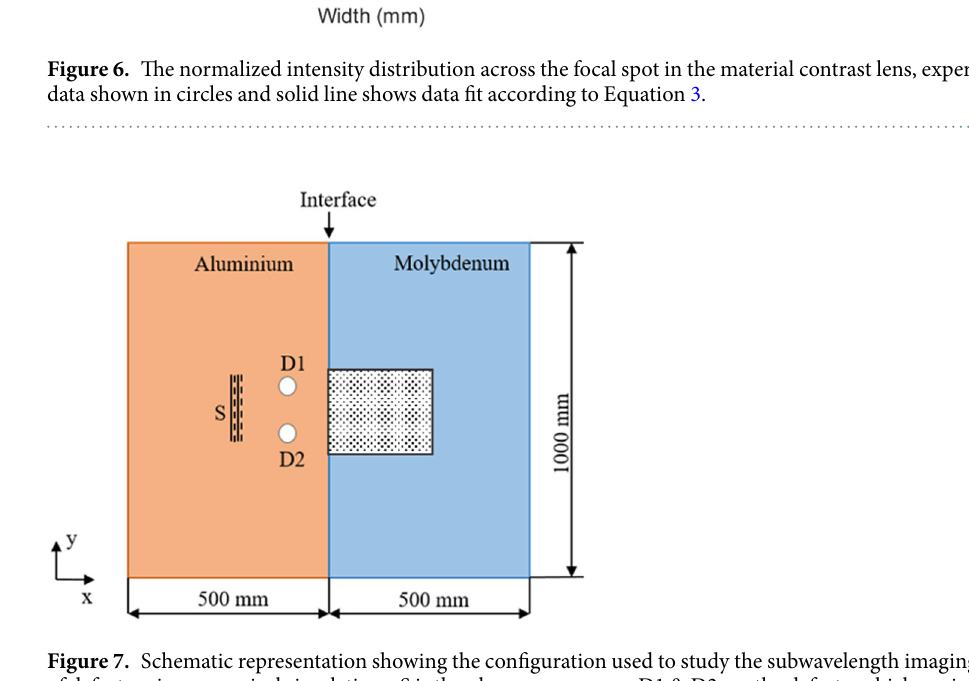
Figure 7. Schematic representation showing the configuration used to study the subwavelength imaging of defects using numerical simulations. S is the plane wave source, D1 & D2 are the defects, which are in subwavelength regime and placed near the interface of the material contrast lens. The dotted area shown on the Molybdenum side is the region selected for imaging of